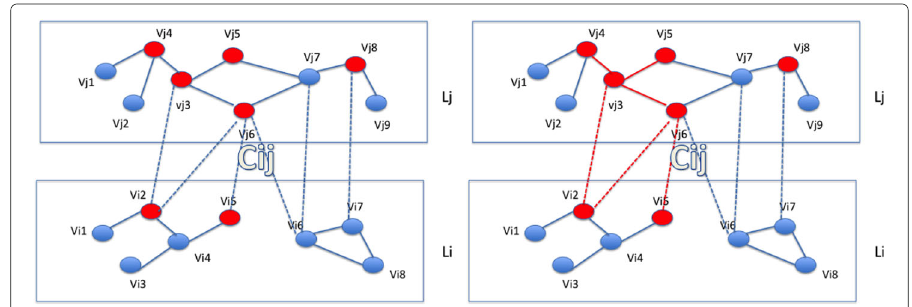
Fig. 4 Multilayer network and private data: blue graph represents the open network, red nodes (on the left) are private data. Red graph (on the right) represents the private network